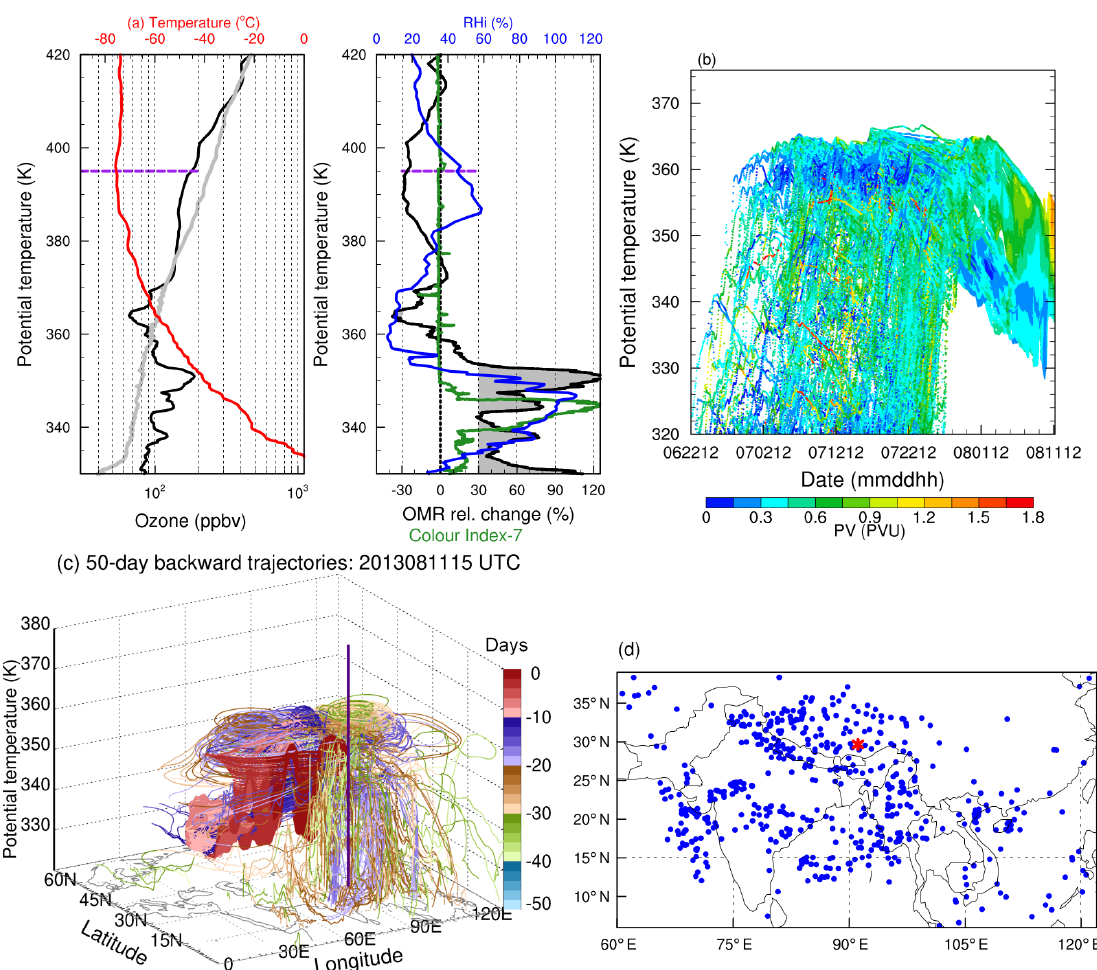
Figure 3. The same as Fig. 2 except for panel (c) but on 11 August 2013. (a) Colour index (CI) minus 7 (CI − 7 > 0 marks the cirrus cloud layer, green line). (c) Three-dimensional backward trajectories colour-coded by